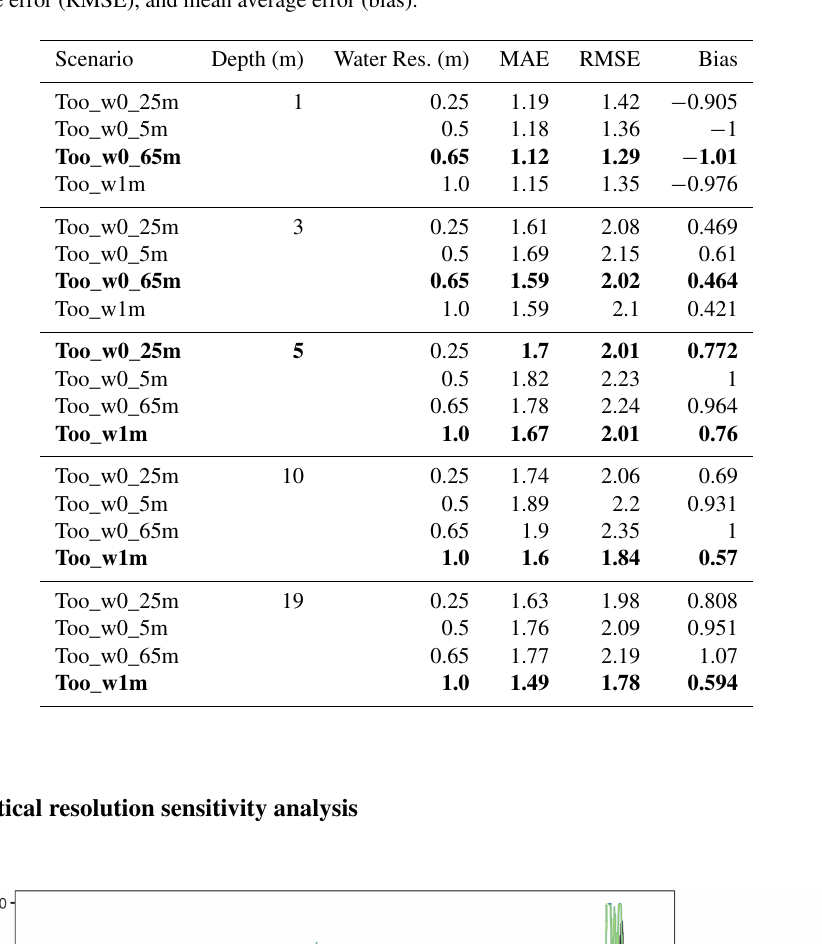
Table D2. Toolik water temperature error calculated from measured water temperatures at multiple depths across different water vertical resolution simulations. Bold rows are the lowest RMSE for a given water depth. The following variables are included: mean absolute error